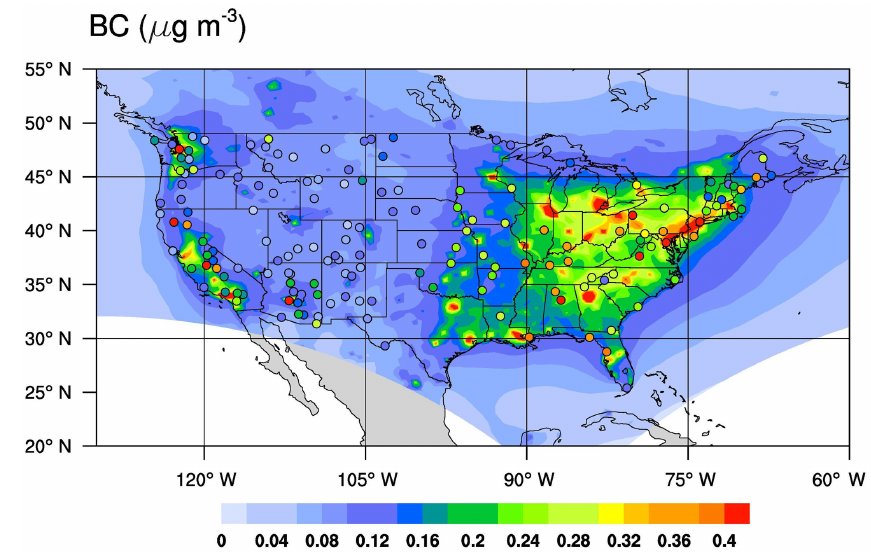
Figure 7. Annual average surface BC concentration over the US. The simulated BC concentration (solid contours) for April 2008 to March 2009 are compared to observations (circles) from the IMPROVE network. The circles indicate IMPROVE sites, with the color representing the BC concentration in µgm − 3 . This figure is generated using NCAR Command Language (NCL) version 6.3.0, open-source software free to the public, by UCAR/NCAR/CISL/TDD, http://dx.doi.org/10.5065/D6WD3XH5 (last access: 13 November